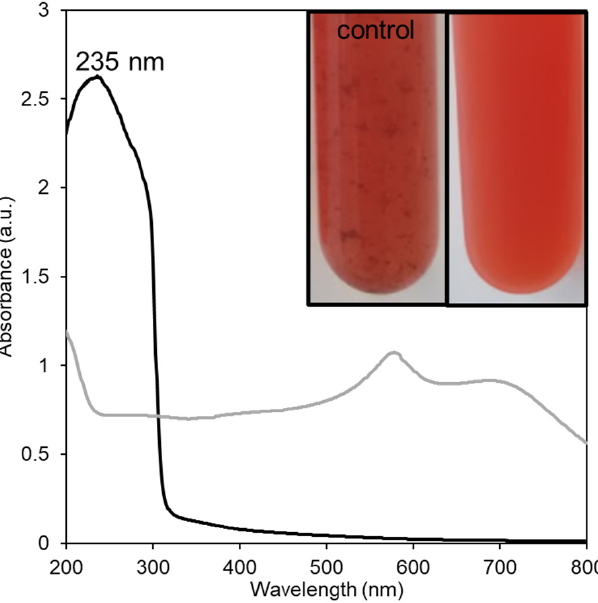
Figure 1. UV-vis absorption spectra and digital photography (insert) of the control (grey line) and the SeNPs bio-nanocomposite prepared with the A. macleodii Mo 169 EPS (black line).